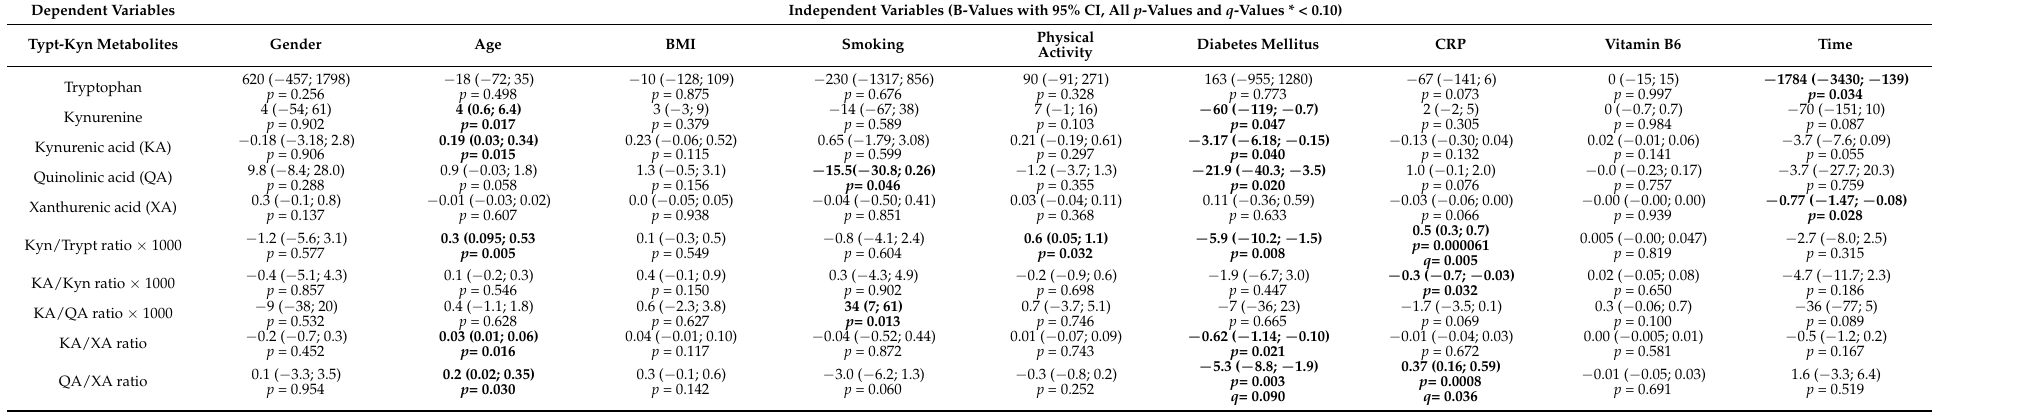
Table 2. Mixed linear regression model with tryptophan, kynurenine, and the metabolites (one at a time) as dependent variables, and Gender, Age, BMI, Smoking, Physical activity, Diabetes mellitus, CRP, Vitamin B6, and Time (before/after surgery) as independent variables.